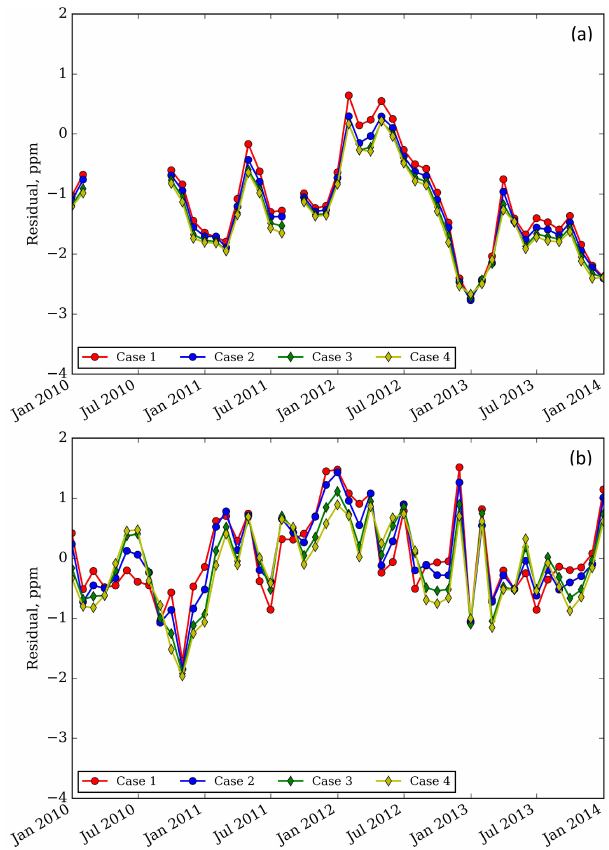
Figure 5. Monthly average residuals of modelled XCO 2 compared with TCCON ground-based FTS for methods C1, C4, C5 and C8, for (a) Darwin and (b)